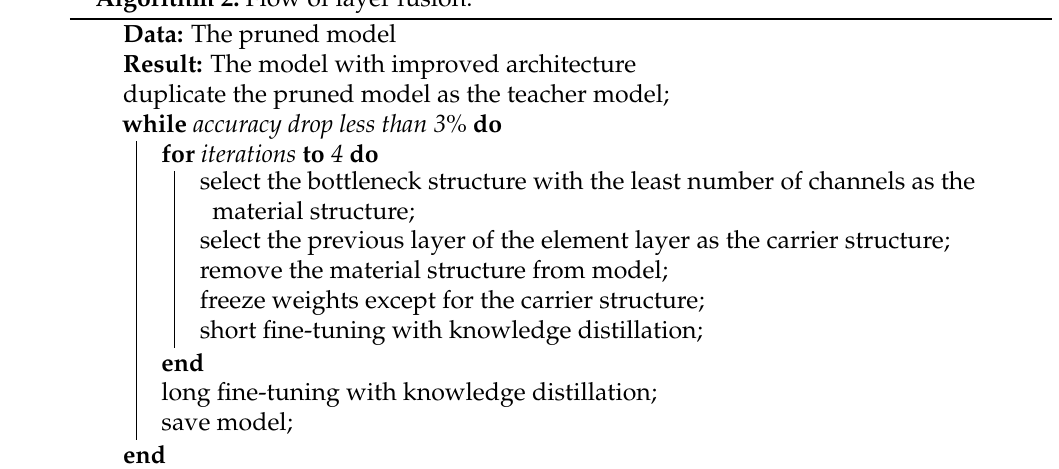
Algorithm 2: Flow of layer